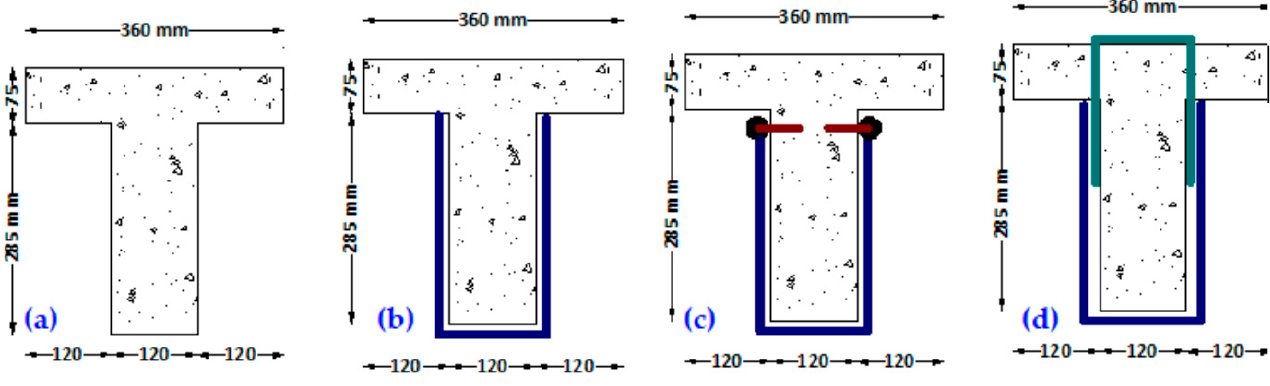
Figure 8. ( a ) R/C T-beam without an FRP strip ( b ) R/C T-beam with an open hoop FRP strip simply attached. ( c ) Open hoop FRP strip anchored with a mechanical anchor. ( d ) Open hoop FRP strip anchored with a rope FRP anchor.